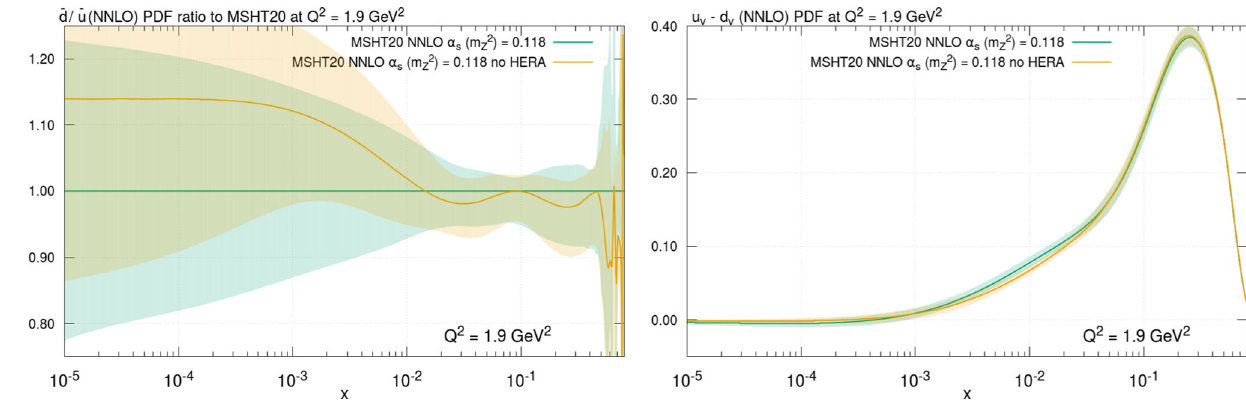
Fig. 74 (Left) ¯ d / ¯ u PDF ratio and (right) u V − d V PDF absolute value compared to the MSHT20 default at Q 2 = 1 . 9 GeV 2 at NNLO showing the effect of removing the HERA data from the MSHT20 default global fit